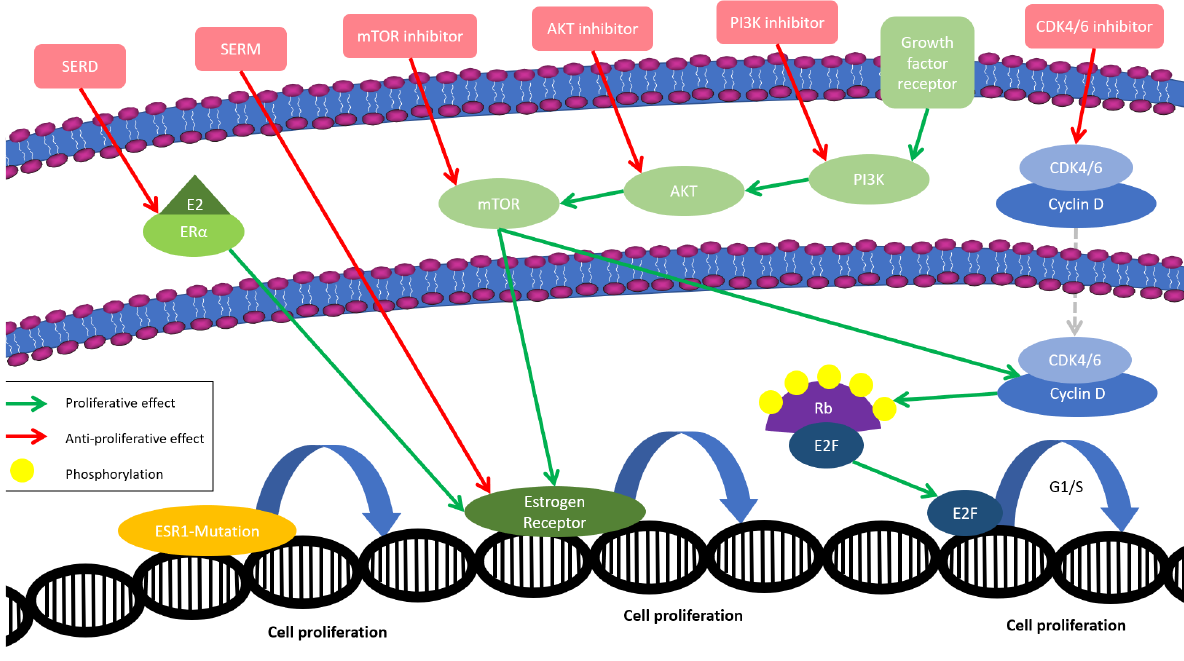
Figure 1. Pathways potentially contributing to endocrine treatment resistance (simplified represen- tation) [14,15]. AKT: AKT murine thymoma viral oncogene; CDK4/6: cyclin-dependent kinase 4/6; E2: estradiol; E2F: transcription factor; ERalpha: estrogen receptor alpha; ESR1: estrogen receptor 1 gene; mTOR: mammalian target of rapamycin; PI3K: phosphatidylinositol 3-kinase; Rb: